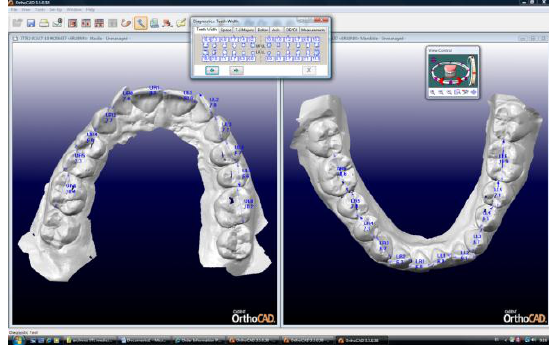
Figure 2. Measurements on 3D models of dental arches